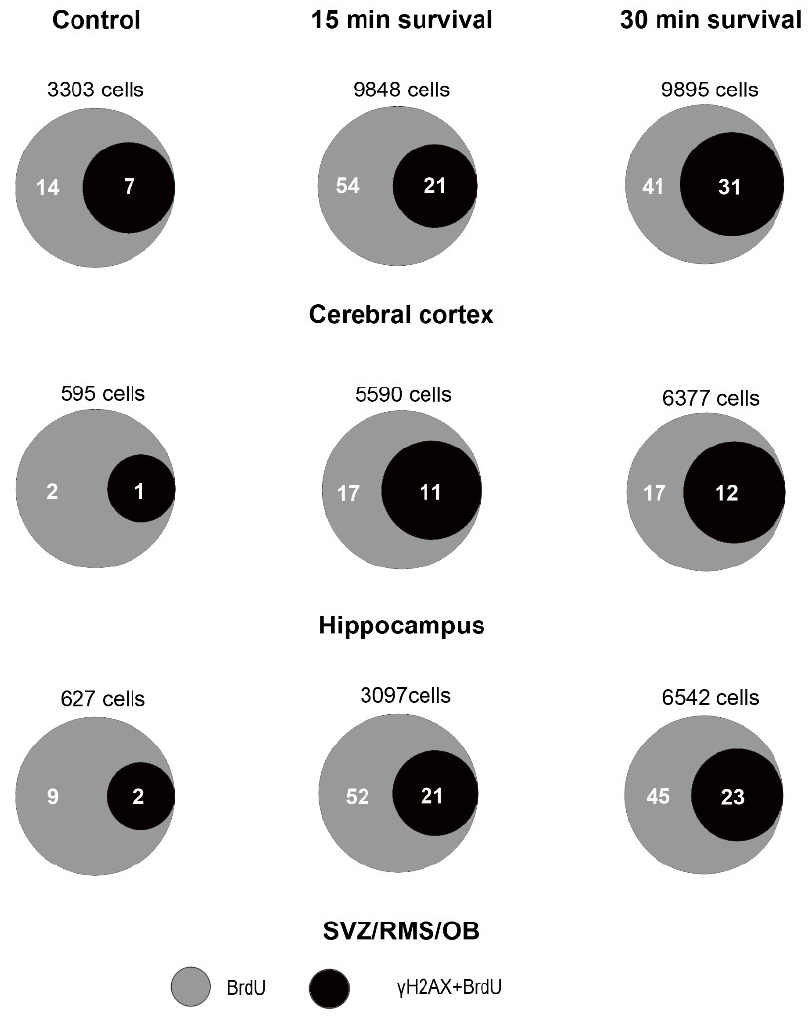
Figure 14. Visual representation with quantitative Venn diagrams of the data presented in Figure 13. Diagrams show the absolute numbers of BrdU single-labeled cells (gray) and BrdU + γ H2AX double- labeled cells (black) after double-labeling experiments. Numbers outside the diagrams are the total number of DAPI-labeled nuclei. Numbers inside the diagrams are the absolute numbers of immunoreactive cells. The fraction of γ H2AX single-labeled cells is not represented for diagram readability. Note that in all experimental settings, double-labeled cells represent a sizable fraction of BrdU+ cells and that this fraction increased with survival time after X-ray irradiation, at least in absolute terms. Figure 15A–C show some exemplificative images of the pattern of BrdU+pHH3 colo- calization in control and irradiated mice. Remarkably, in response to X-rays, both BrdU and pHH3 display immunoreactivity in foci. This pattern for pHH3 is typical of cells at the G 2 and/or G 2 /M transition phase of their cycle [34]. We never observed pHH3 mitotic chromosomes. (Figure 15D–G) demonstrate the results of X-ray exposure onto the volumetric density of BrdU+pHH3 immunoreactive cells after statistical analysis. From their inspection, it appears that irradiation not only led to increased incorporation of BrdU as above shown (Figures 12 and 13), but also to augmented numbers of BrdU+pHH3 double-labeled cells in the cerebral cortex (Figure 15E) and SVZ/RMS/OB (Figure 15G), but not hippocampus (Figure